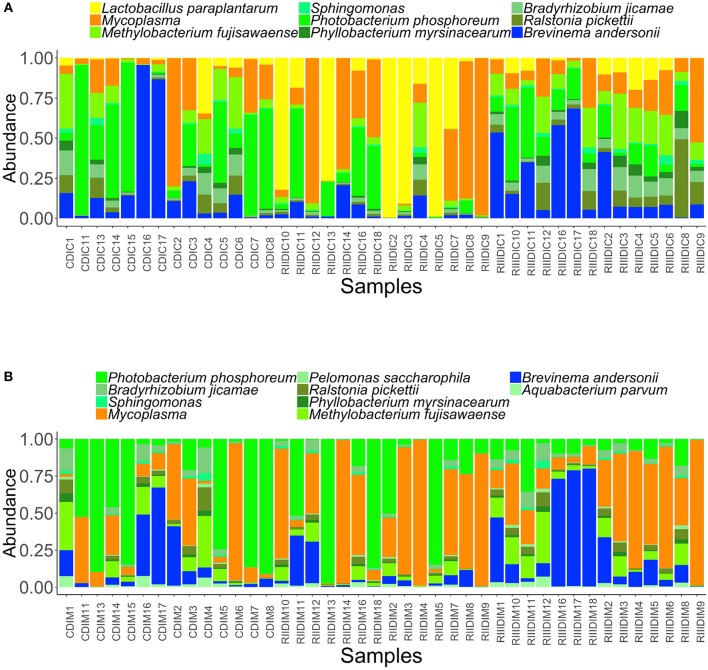
Abundance of the core bacterial taxa in the intestinal content (A) and mucus (B). Color codes: Shades of green—Proteobacteria, yellow—Firmicutes, dark blue—Spirochaetes, and dark orange—Tenericutes.